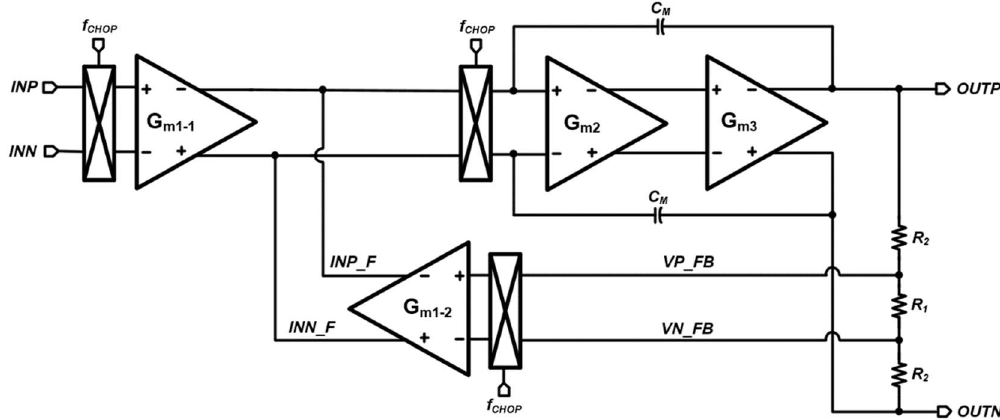
Figure 9. Block diagram of the proposed potentiostat readout circuit.